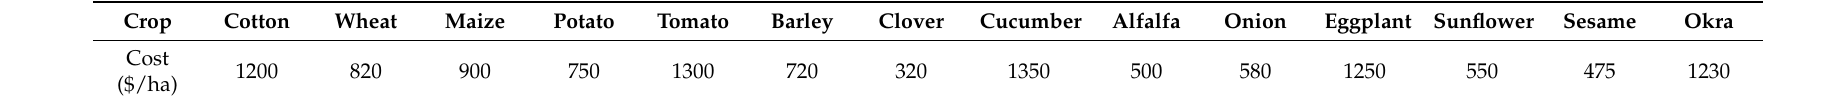
Table 2. Crop production costs exclusive of water costs (US $ per ha).